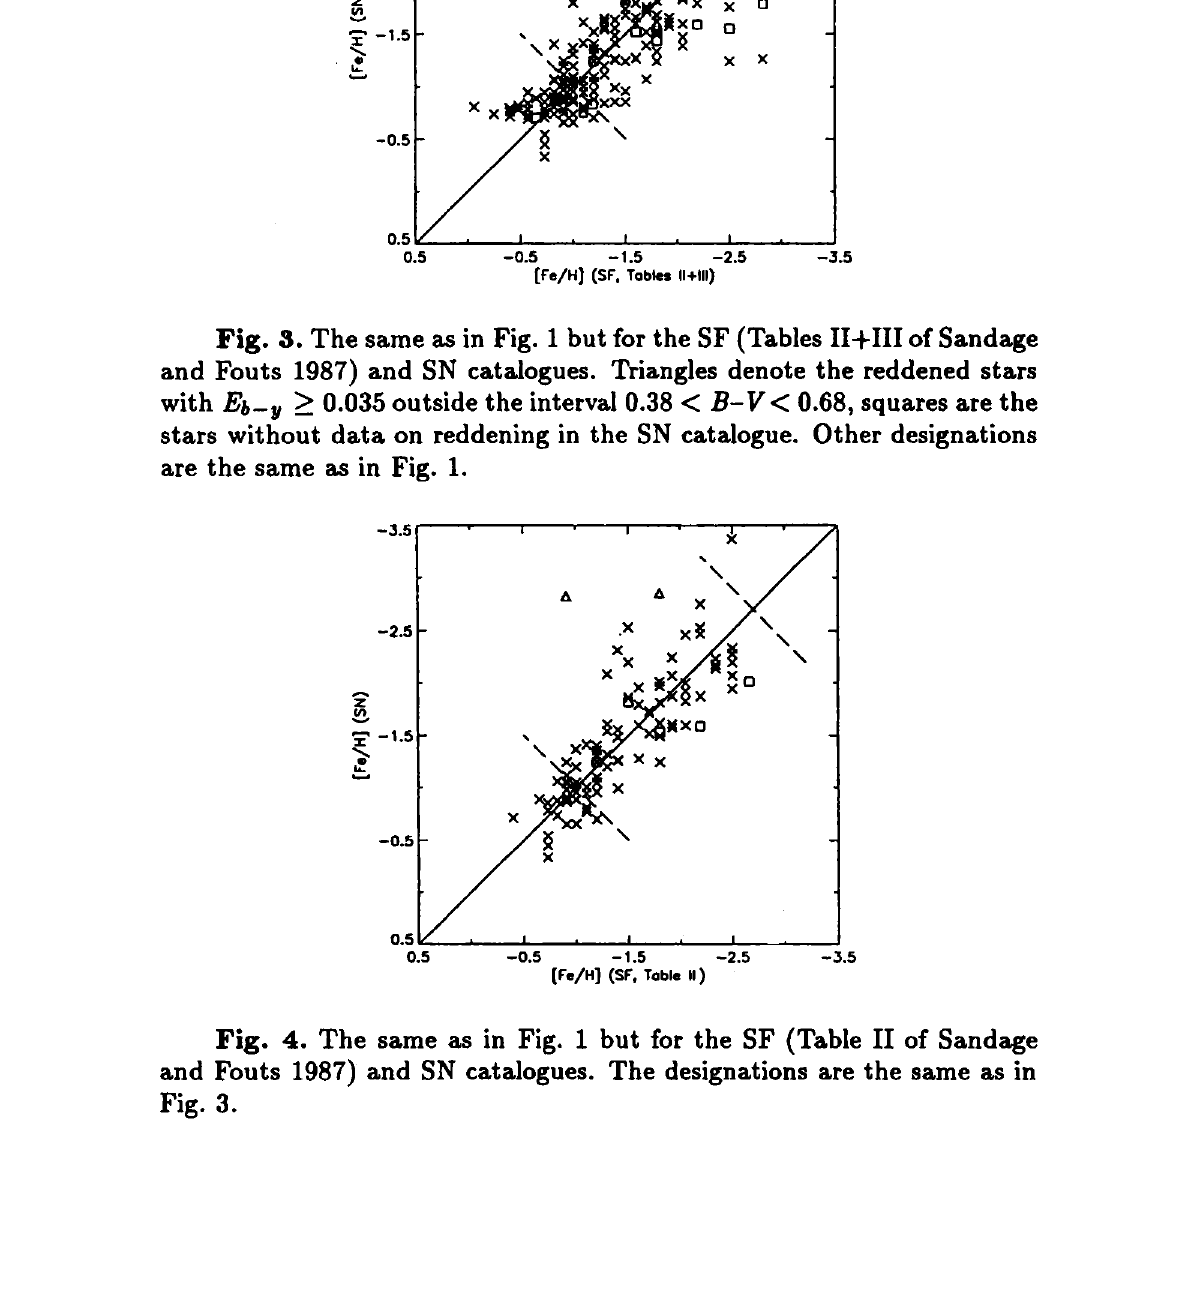
Fig. 4. The same as in Fig. 1 but for the SF (Table II of Sandage and Fouts 1987) and SN catalogues. The designations are the same as in Fig.